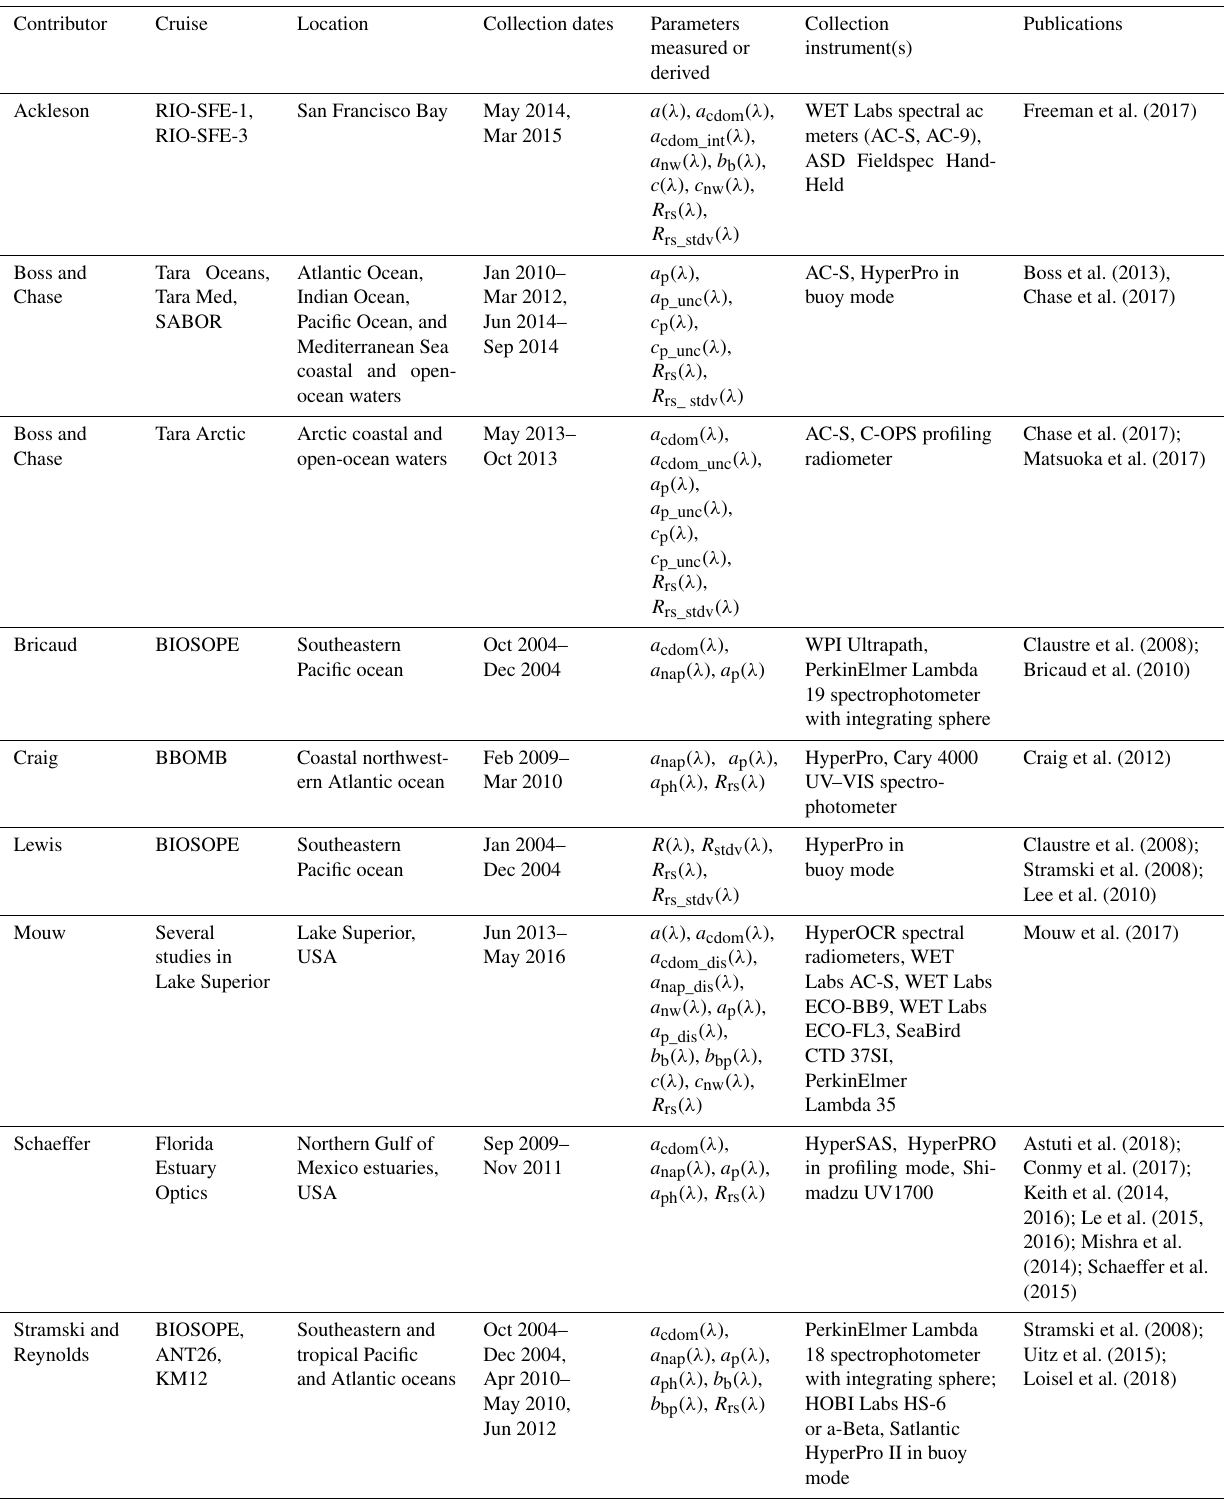
Table 2. In situ data collection instrument, logistical details and related